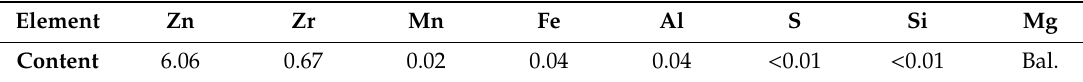
Table 1. The composition of ZK61 alloy (wt %).